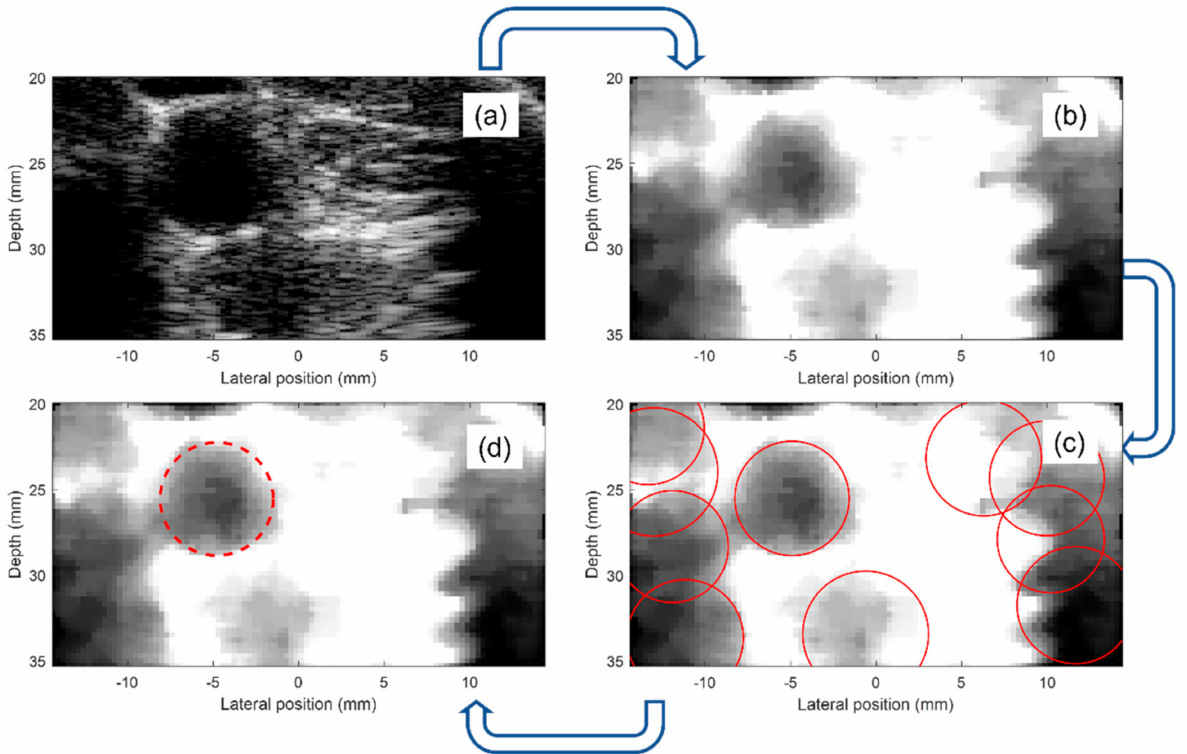
Figure 2. Procedure for automatic carotid segmentation. ( a ): The raw B-Mode image is acquired; ( b ): the image is pre- processed; ( c ): candidate carotids (red circles) are detected; ( a – c ) is repeated over 15 images to obtain the candidate matrix; ( d ): the final segmentation is